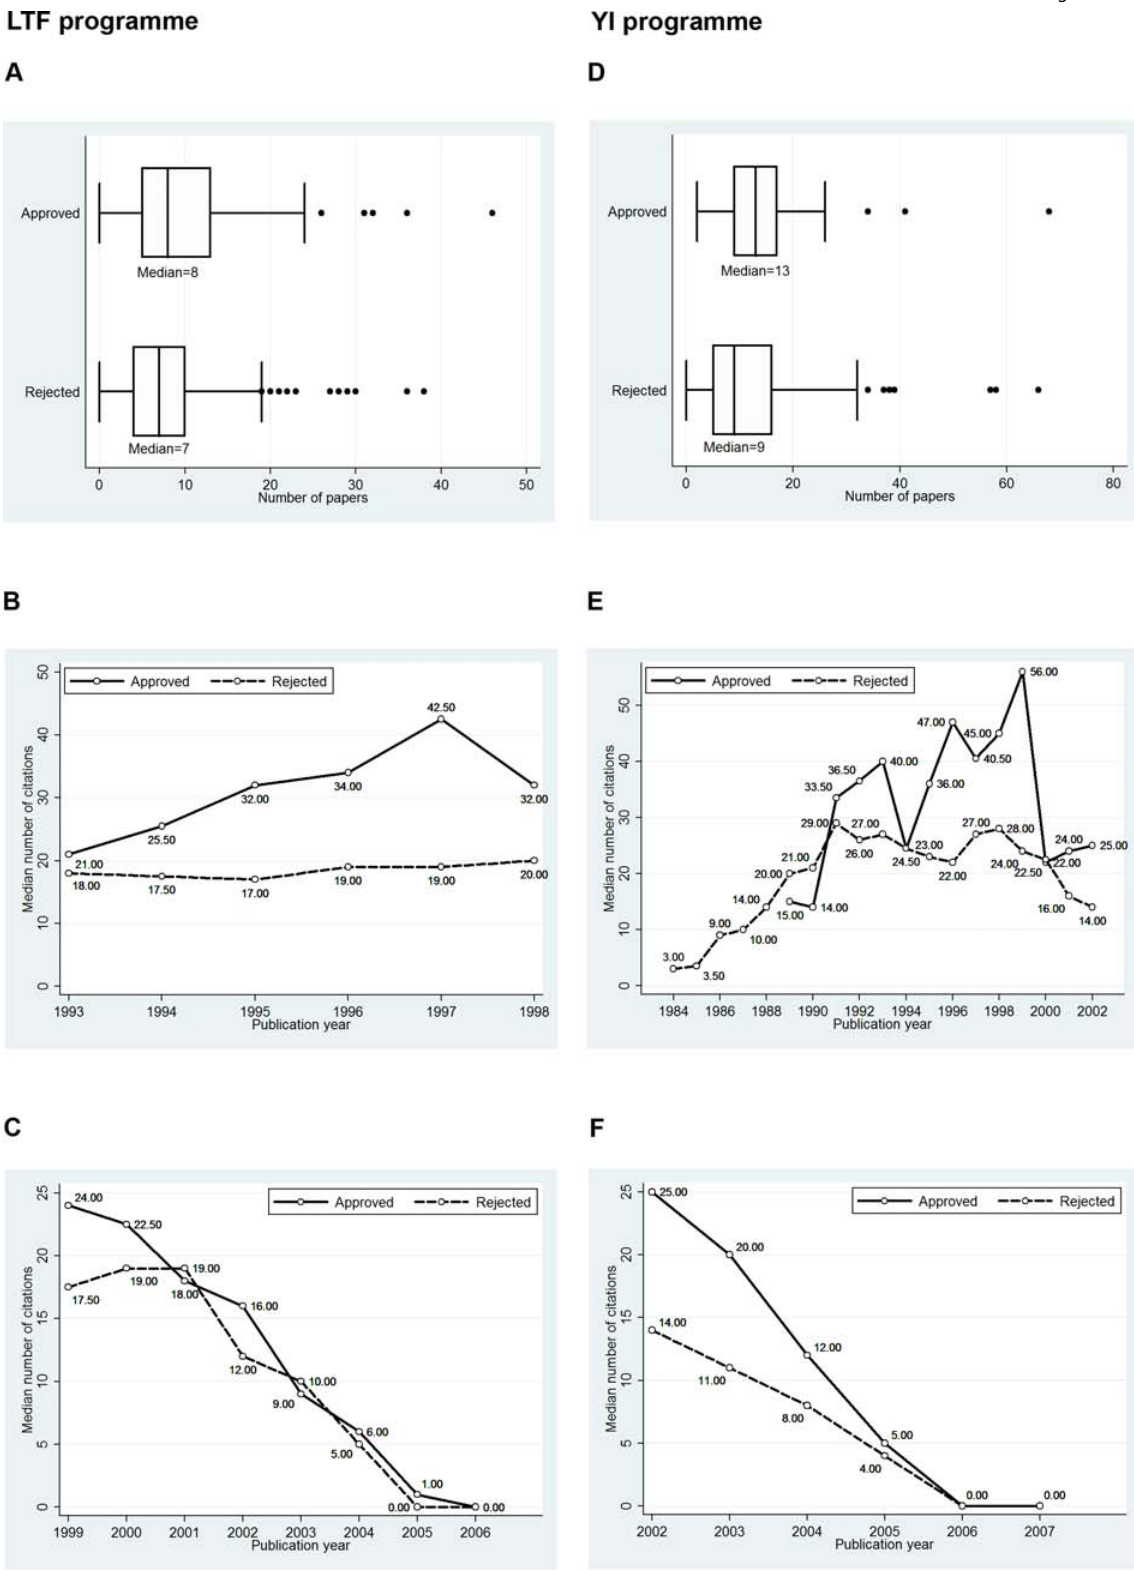
Figure 2. Box plots for the number of papers published subsequent to application (first row). Median numbers of citations for papers published prior to application (second row) and median numbers of citations for papers published subsequent to application (third row) (approved and rejected applicants for the LTF and YI programme). Note . Applications from 1998 (LTF programme) and 2001/2002 (YI programme); publication windows: from 1993 to the beginning of 2006 (LTF programme), from 1984 to the beginning of 2007 (YI programme); citation window: from year of publication to the beginning of 2006 and 2007, respectively. Since the downloading of citation counts was done in 2006 and 2007, respectively, one cannot expect high median citation counts yet for the most recent publications (see the graphs in the third row of the figure). doi:10.1371/journal.pone.0003480.g002 PLoS ONE |